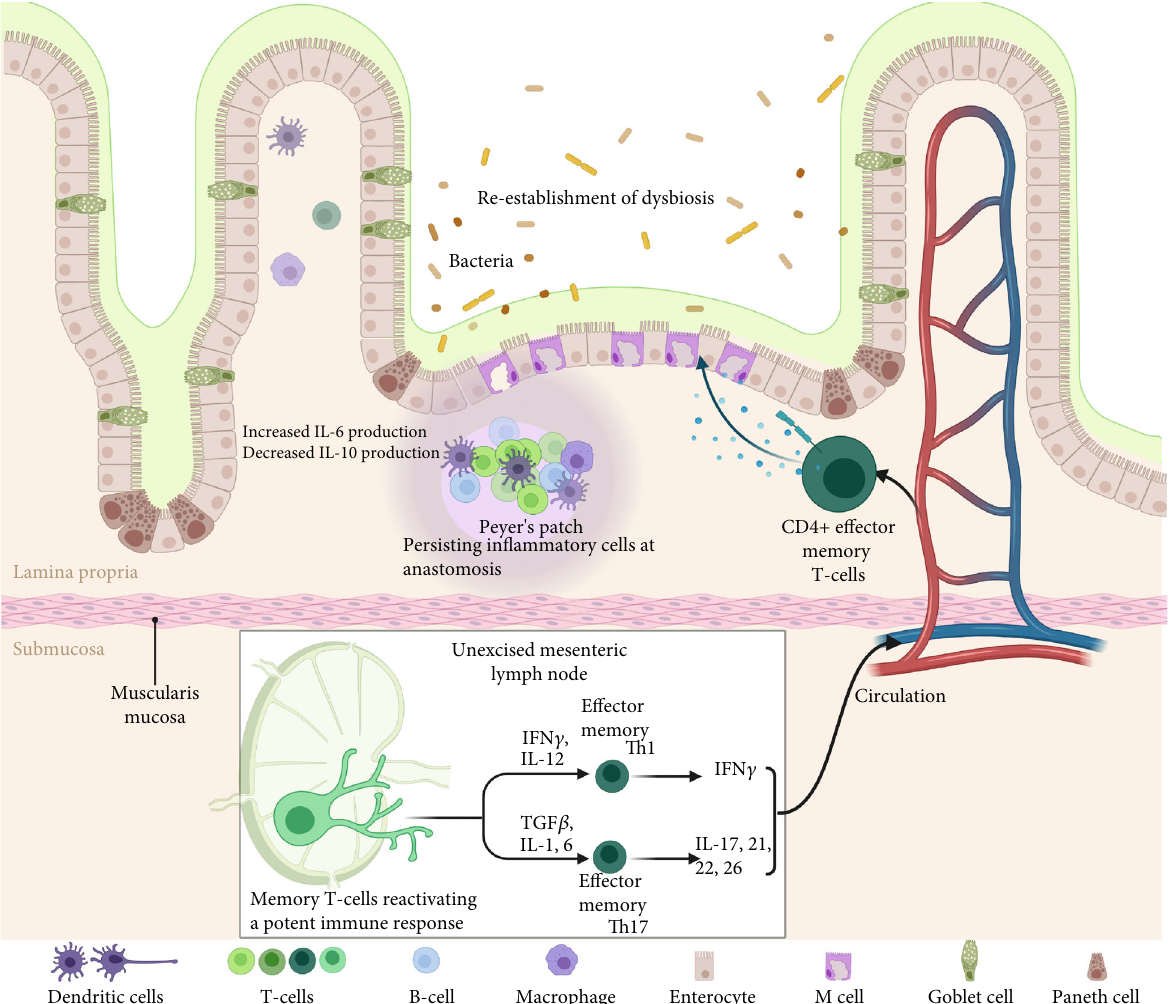
Figure 2: Pathogenesis of Crohn ’ s disease recurrence. Created with